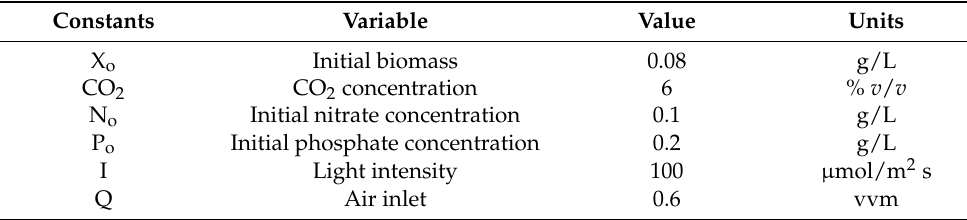
Table 1. Biomass production variables.